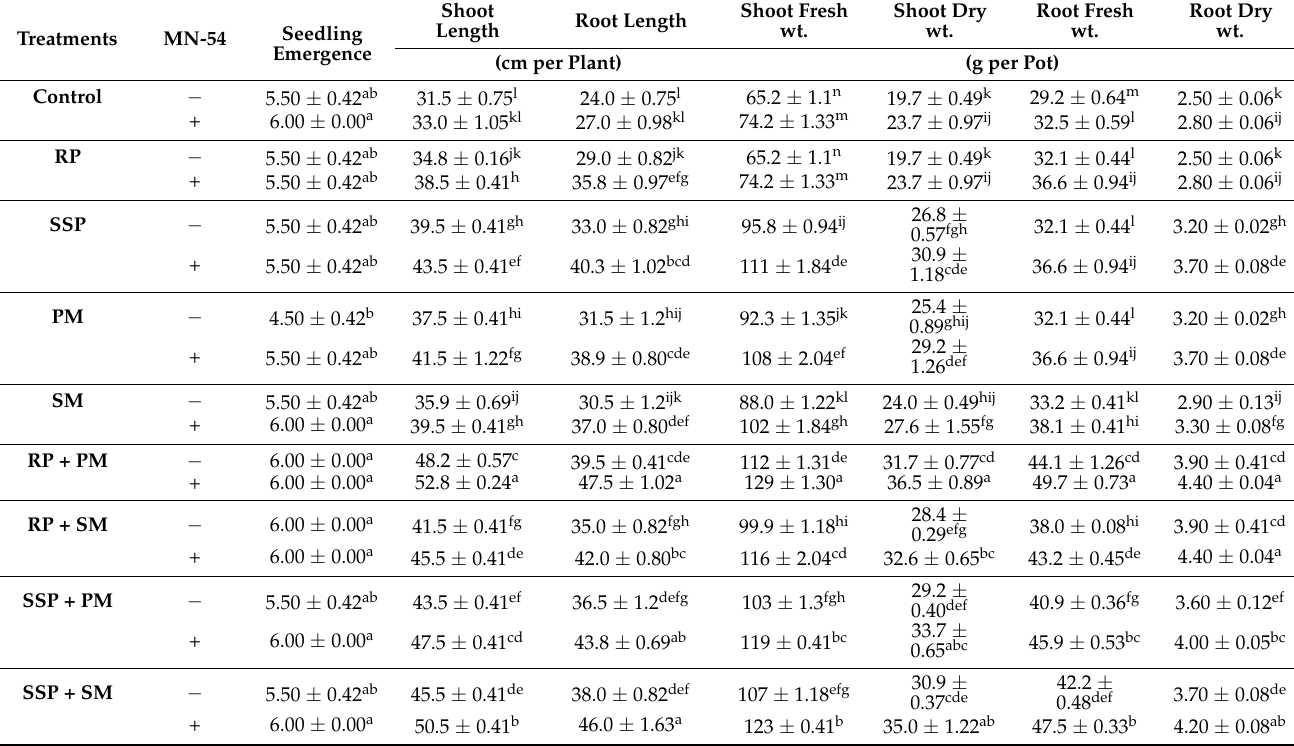
lengths of chickpea. Table 2. Effect of phosphorus fertilizers, organic manures, and Bacillus sp. MN-54 addition on seedling emergence and growth of chickpea. Treatments